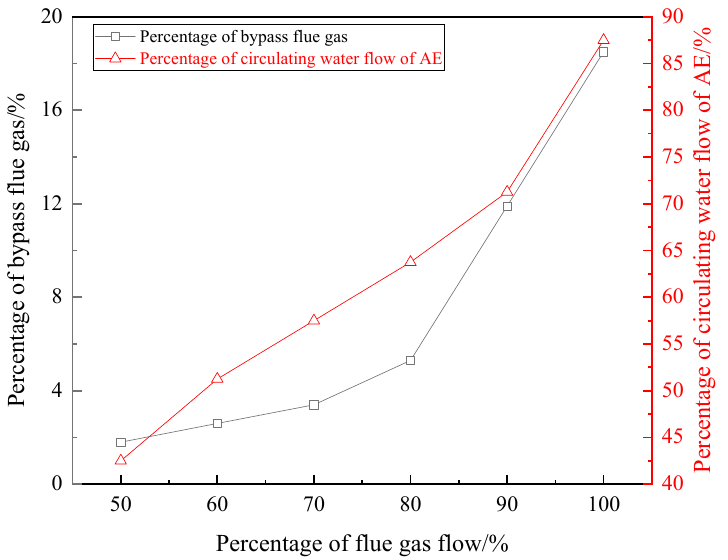
Figure 8. Adjustment curve as flue gas flow changed.